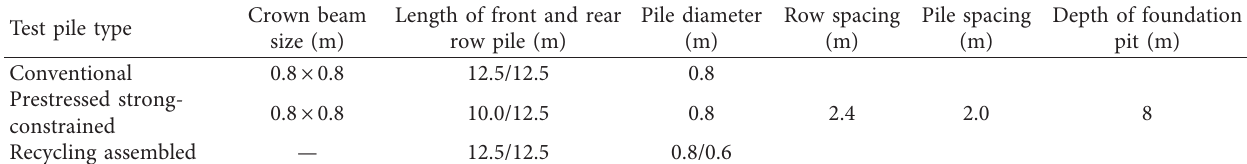
Table 1: Geometric design parameters of test piles.